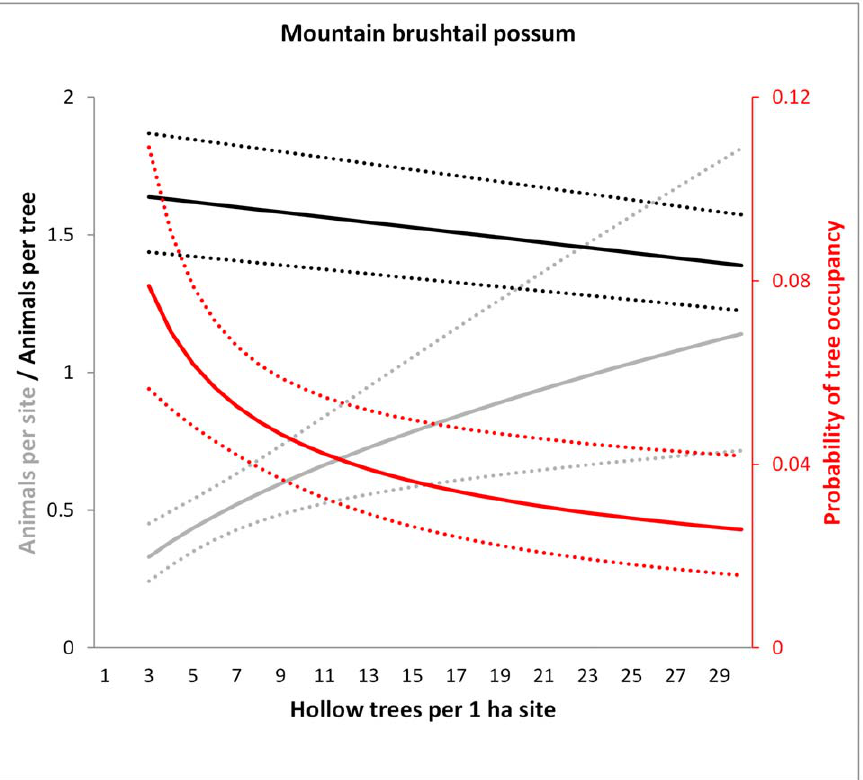
Figure 3. Model predictions for the mountain brushtail possum of the number of animals per site (grey), the probability of occupancy per tree (red) and the number of animals per occupied tree (black) in relation to the number of hollow trees per 1 ha site. Dotted lines show 95% confidence intervals. Predictions were averaged over the non-represented variables (e.g. tree form).